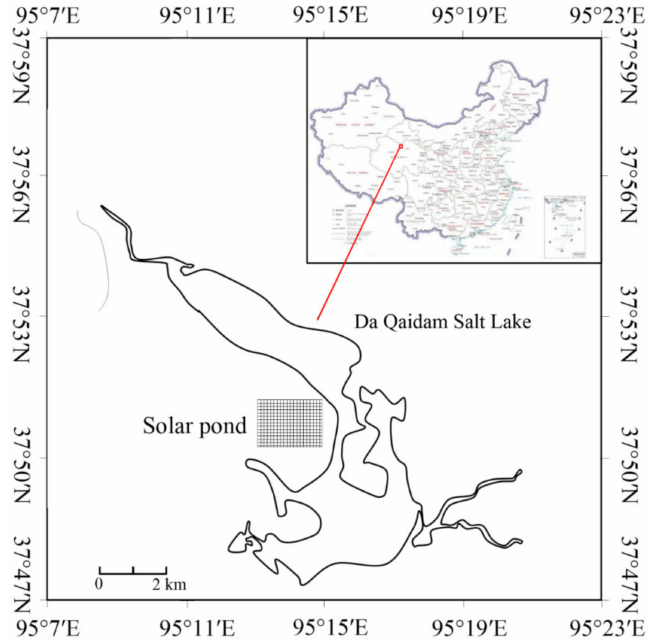
Figure 1. The map of the study area.